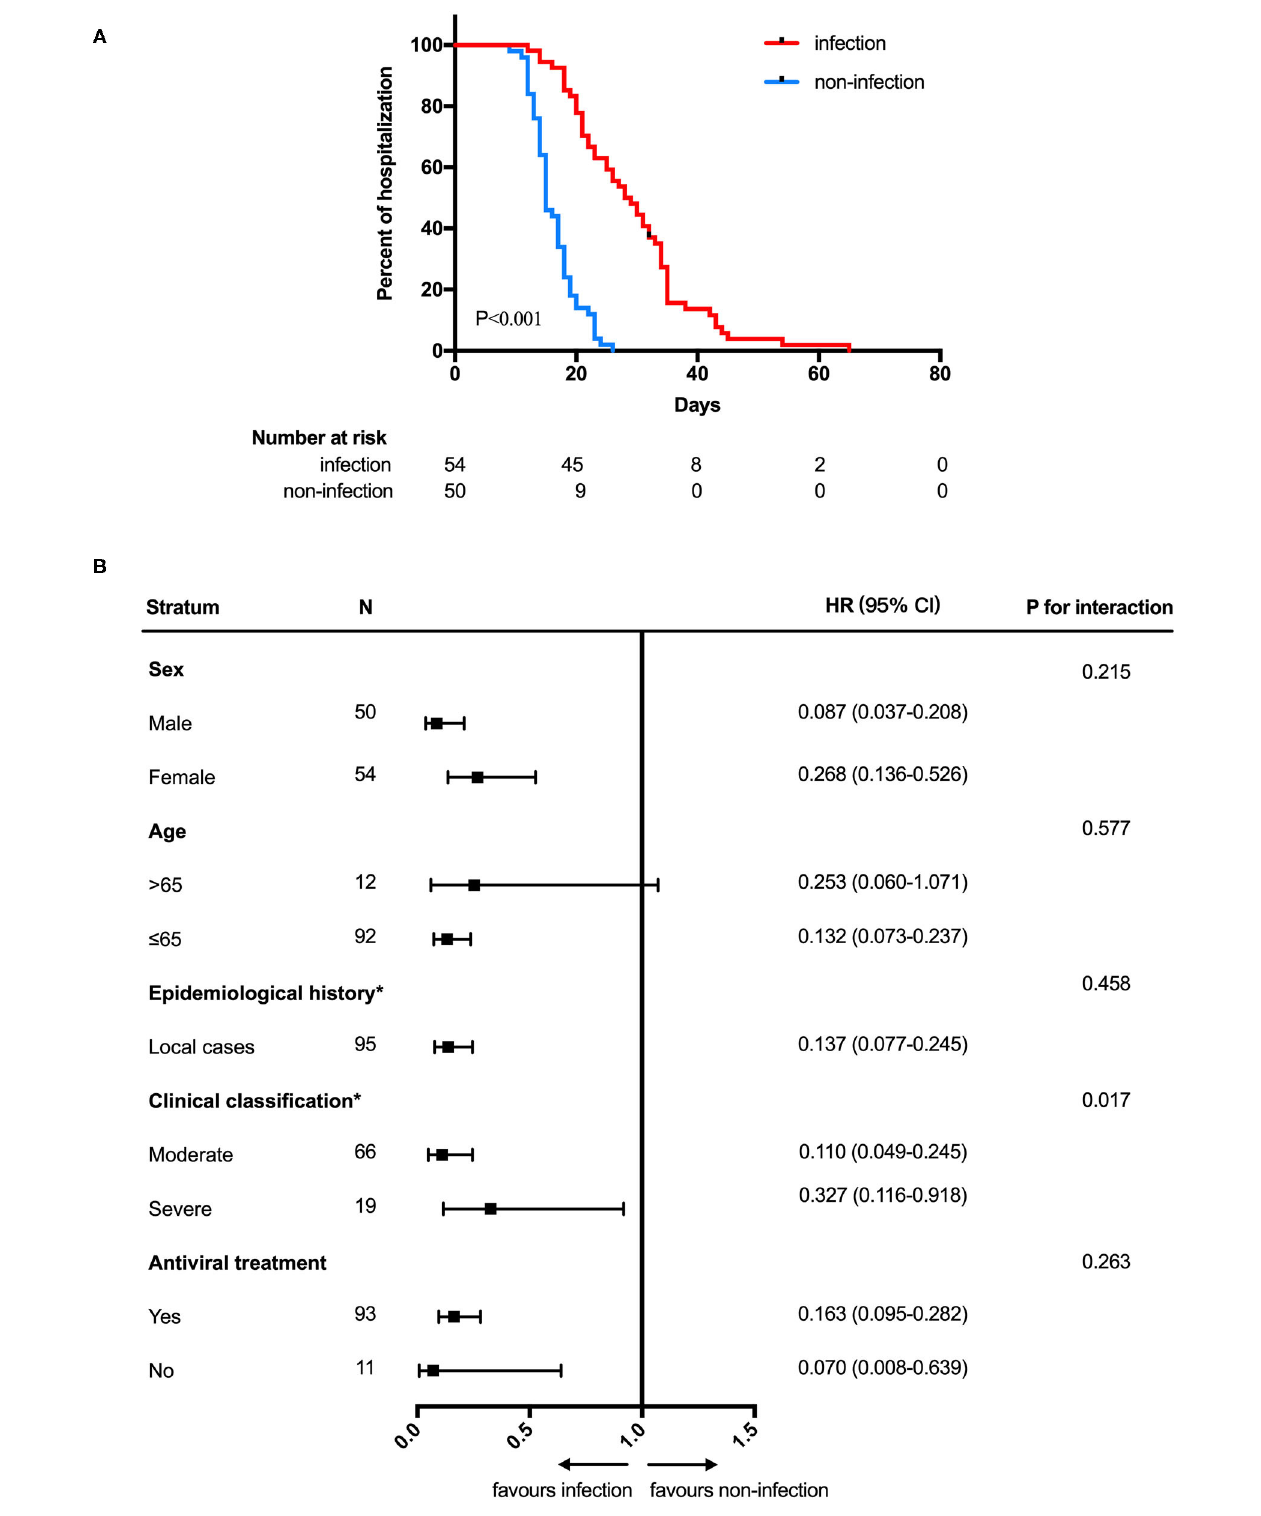
FIGURE 2 | Hospitalization time (A) Kaplan-Meier curve for hospitalization time between SARS-CoV-2 gastrointestinal infection and non-infection groups. (B) Subgroup analysis. HOD, hospitalization days; HR, hazard ratio. *The number of patients in the overseas case subgroup as well as the mild and critical subgroups were too few for